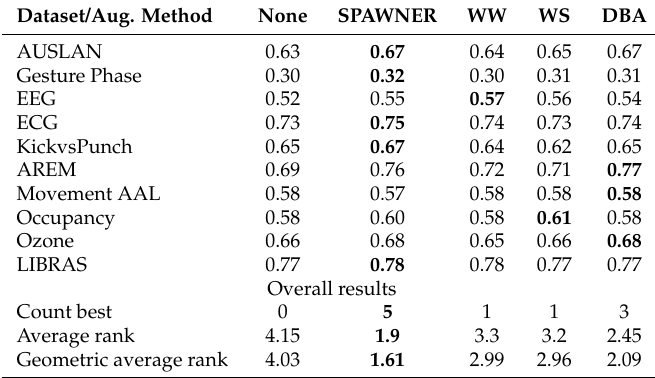
Table 3. Experimental comparison of augmentation methods using NN-DTW classifier and few number of examples per class. Average accuracy for a dataset is reported (see Figure 3). The greatest value used in the rank is written in bold and rounded to two significant figures.